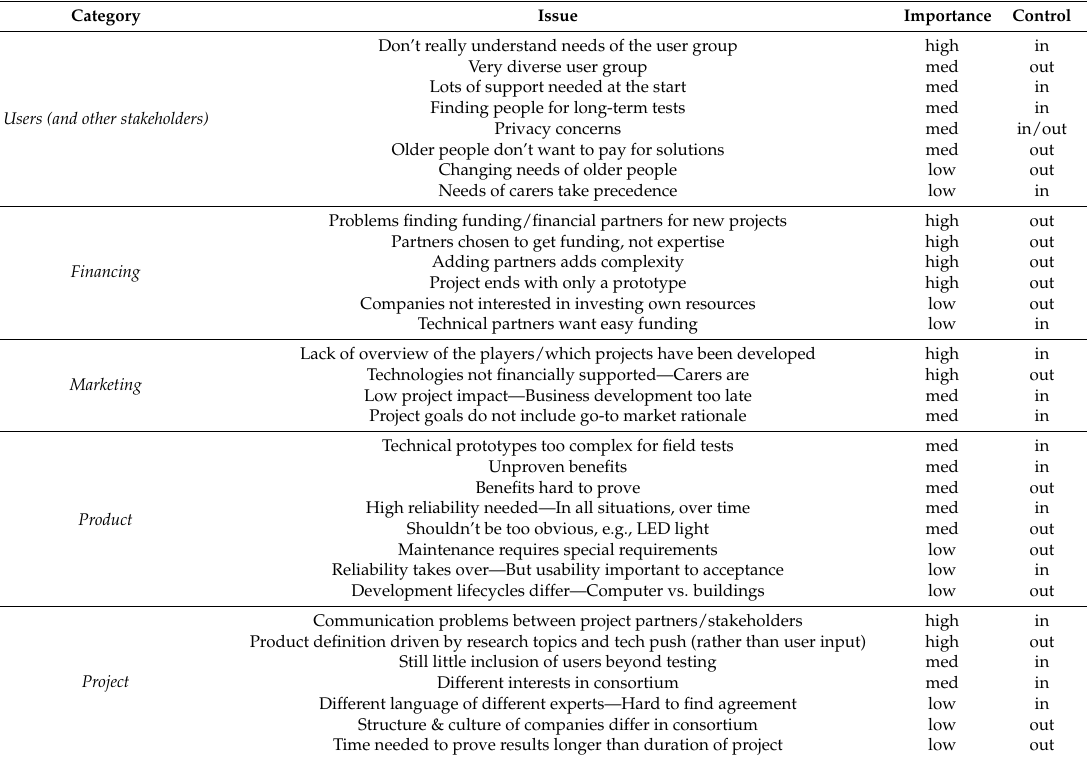
Table 2 grouped by the categories identified in the workshops. Of these, nine were rated by participants to be most important to success (i.e., were placed in the dark ring). These are labelled with “high” in the column “Importance” in the table. Table 2. Issues confirmed from multiple sources, grouped by